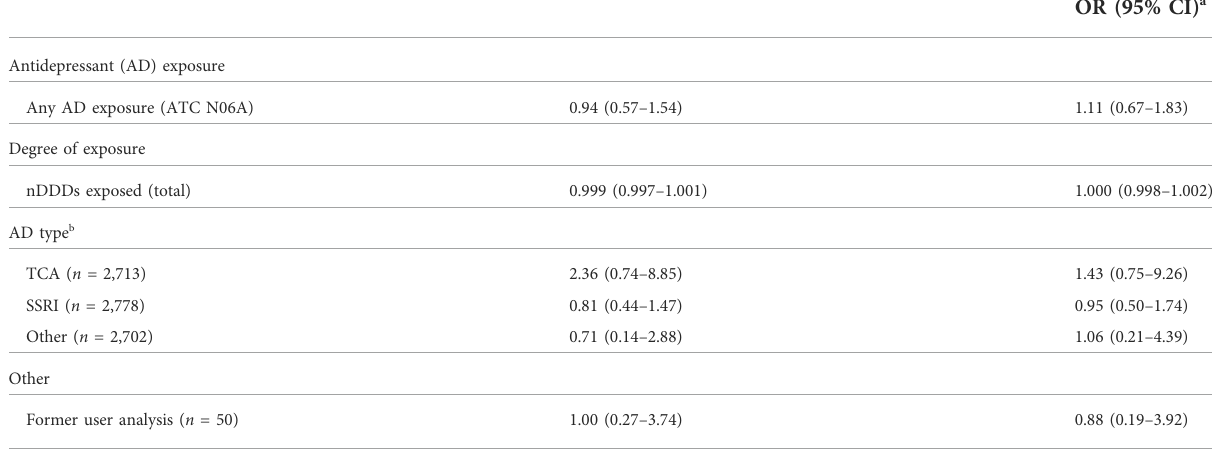
determinant in the model, an aOR of 1.000 (0.998 – 1.002) was found. When stratifying the type of AD that the pregnancy was exposed to, no statistical increases or decreases in the odds of ADHD in offspring following in utero exposure to ADs were found. For the exploratory analysis on sex of the offspring as an effect modi fi er, it was found that the interaction term was not signi fi cant: aOR = 0.76 (95% CI 0.24 – 2.24) with male sex as the reference.